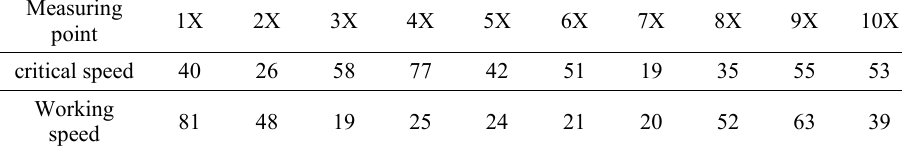
Table 1. Vibration data at the first constant